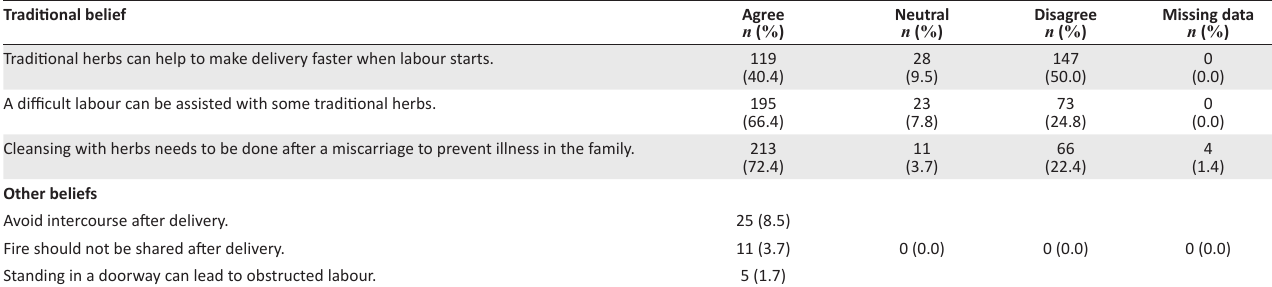
Standing in a doorway can lead to obstructed